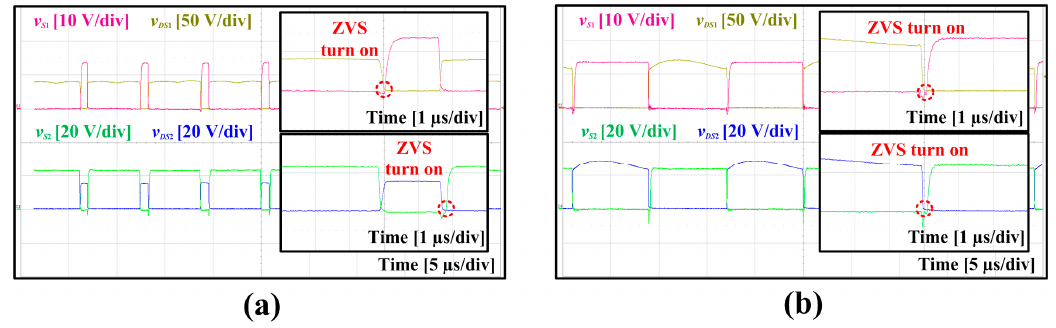
Figure 12. Gate-source and drain-source voltages of S 1 and S 3 for ( a ) D ≤ 0.5 and ( b ) D > 0.5.